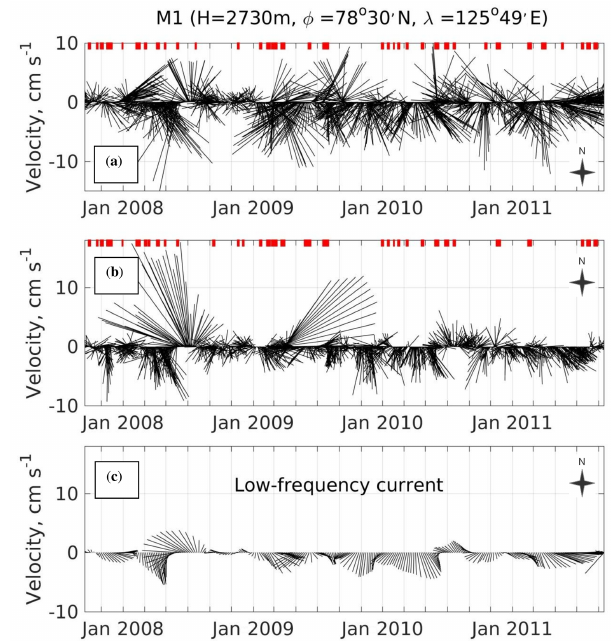
Figure 2. Daily current vectors at mooring M1f measured by the MMP instrument in the Atlantic Water temperature core at 254m (as defined by maximal temperature) and at the deepest observa- tional level (780m; b ). Strong current rotation, evident in both series, indicates multiple events of eddies passing (red markers) through the mooring site. (c) Low-frequency current averaged over the water column spanned by the MMP velocity observations (every fifth vector is shown). Note that from mid-2008 to the end of 2010, the prevailing eastward velocity component was